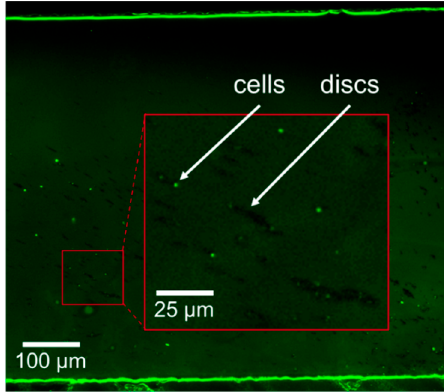
Figure 9. Example image of isolated aptamer-functionalized magnetic microdiscs / bacteria conjugates using the µFMS device and a flow rate of 120 µL/s.